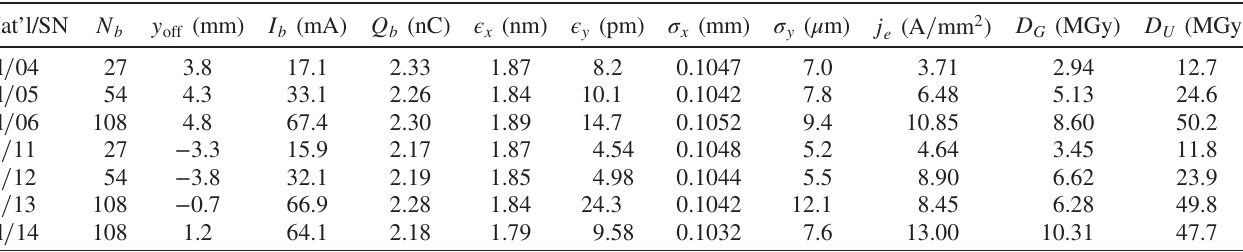
TABLE V. Material and chronological sequence number (SN), number of bunches N b , y offset, beam current, I b , charge per bunch, Q b , emittances, spot sizes σ x;y , current density j e , peak Gaussian profile dose D G , and maximum dose predicted by MARS using the APS-U loss distribution, D U , during the May 2019 S37 collimator study. Mat ’ l Al refers to aluminum alloy T6061 and Ti stands for titanium alloy Ti6Al4V.